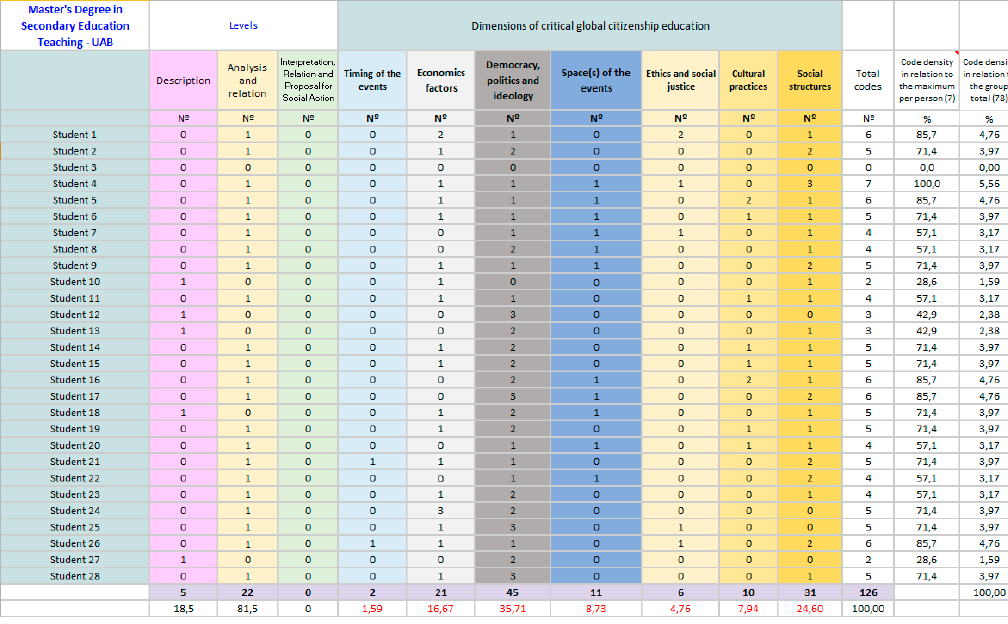
Figure 5. Data emptying matrix—University of Barcelona (UAB).